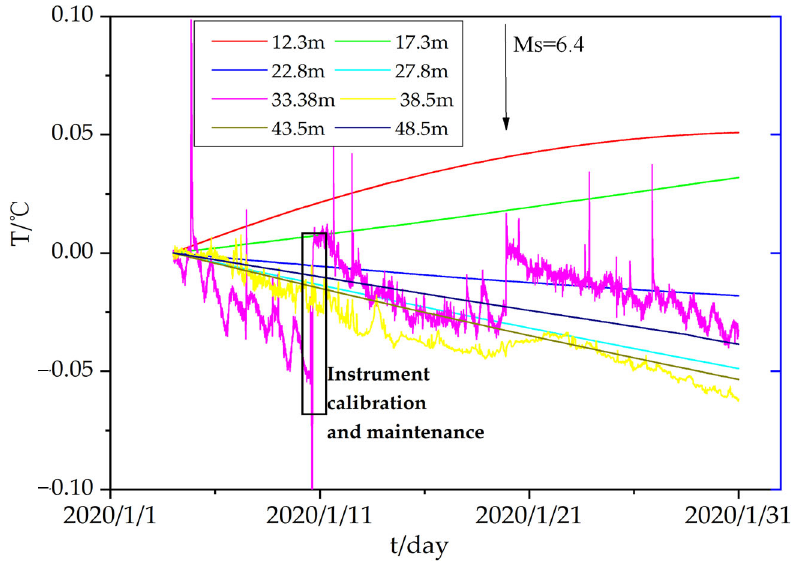
Figure 2. Time series of ground temperature in each layer of the XKE ground temperature observation station.